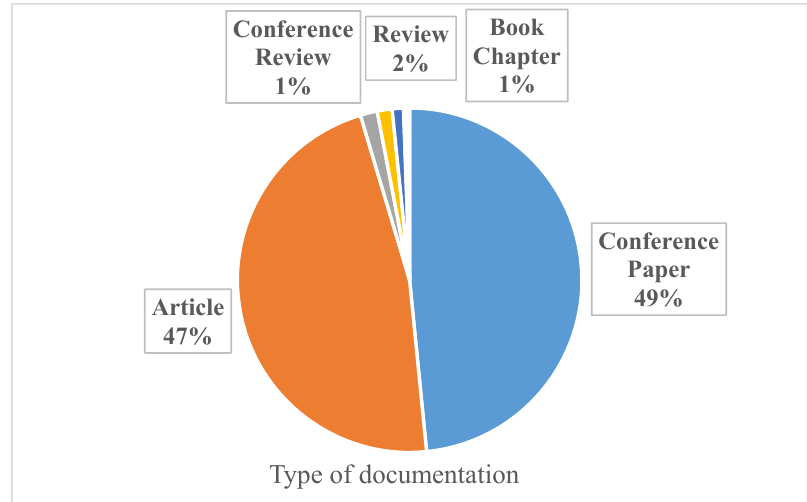
Figure 5. Type of published articles.